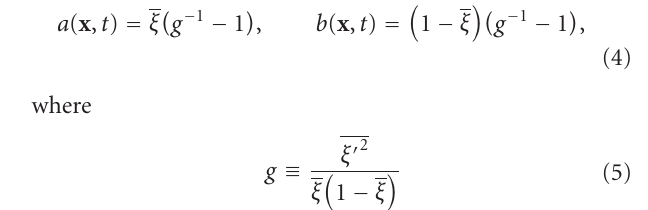
(cid:3) (cid:2) P ( ξ ) dξ with 0